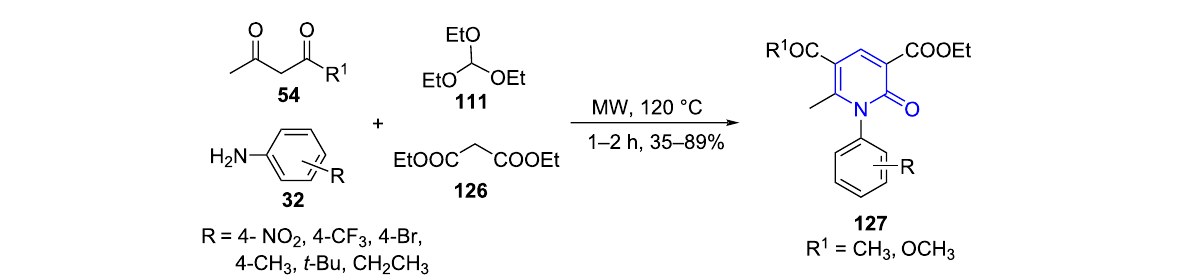
Scheme 48: Two possible mechanisms for pyridone synthesis.